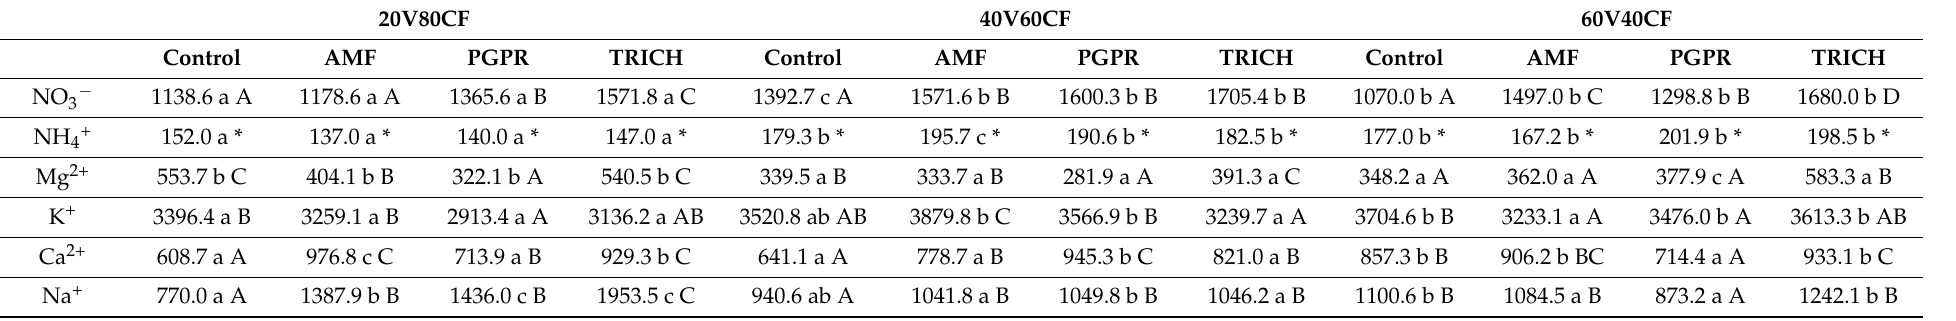
Table 7. Sap analysis (mg L − 1 ) of main cations and anions in the tomato crop between substrate treatments and PGPMs